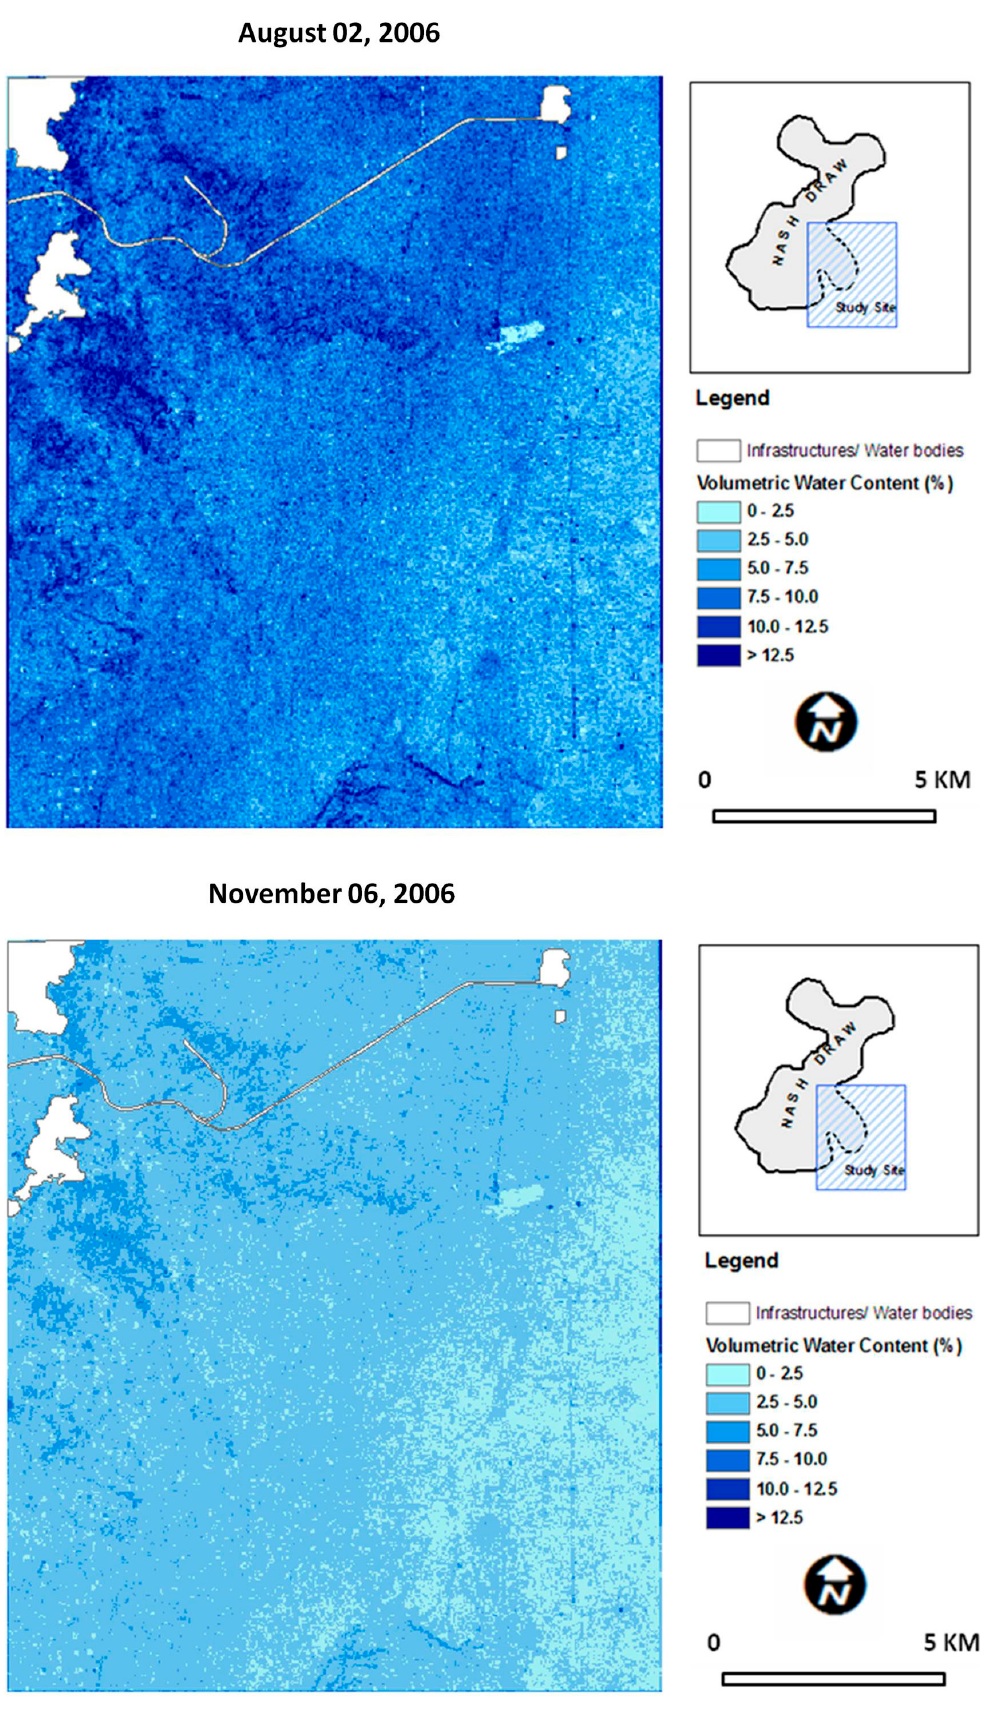
Figure 11. Classified soil moisture data generated for the study site.